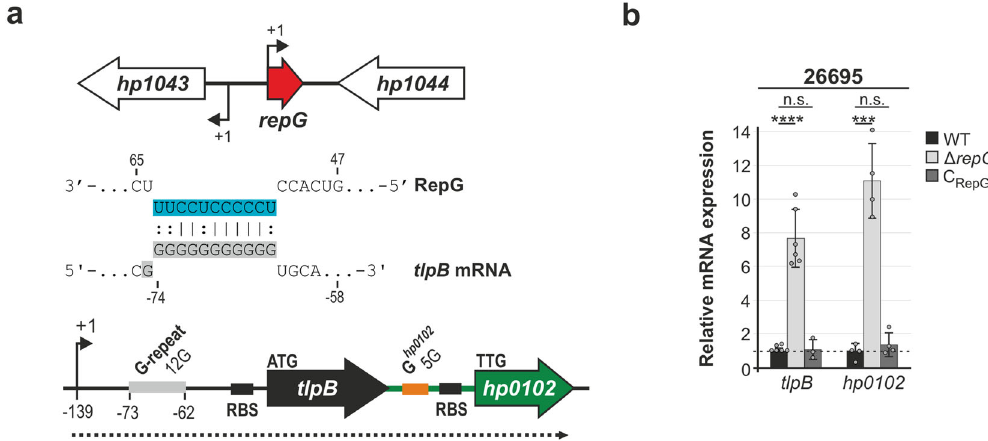
Fig. 1 RepG sRNA represses expression of the tlpB - hp0102 mRNA. a In H. pylori strain 26695, RepG sRNA is transcribed from the intergenic region between hp1043 and hp1044 , encoding an orphan response regulator and a protein of unknown function. The C/U-rich terminator loop of RepG (blue) binds to a homopolymeric G-repeat (12G, light gray) in the 5 ′ UTR of the bicistronic tlpB - hp0102 mRNA (dotted line), encoding a chemotaxis receptor and a protein of unknown function 21 . Transcriptional start sites (TSS, + 1; ref. 28 ) and ribosome binding sites (RBS) are indicated by arrows and black bars, respectively. Numbers designate the distance to the tlpB start codon. A G-rich sequence (G hp0102 , orange) was identi fi ed in the tlpB - hp0102 IGR. b RT-qPCR analysis of RepG-dependent regulation of tlpB and hp0102 in H. pylori strain 26695 wildtype (WT), repG deletion ( Δ repG ), and complementation (C RepG ) mutants. Wild-type mRNA levels of each gene were set to 1, and relative mRNA levels in mutants are shown as bars. Values are shown as mean ± standard deviations (s.d.) for n = 6 ( tlpB ; exception C RepG n = 3) and n = 4 ( hp0102 ) biologically independent experiments. **** — highly signi fi cant, p -value < 0.0001;